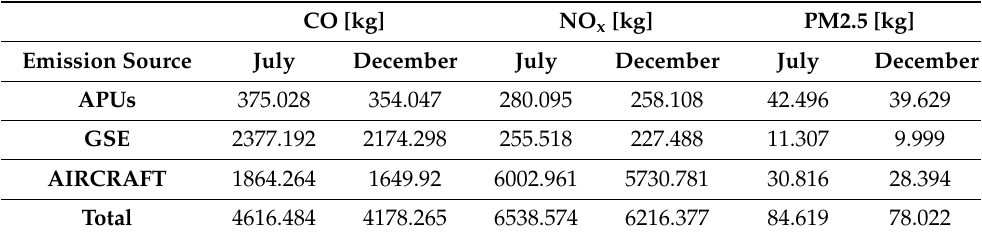
Table 5. Summary of emissions by APU, GSE and aircraft. CO [kg] NO x [kg] PM2.5 [kg] Emission